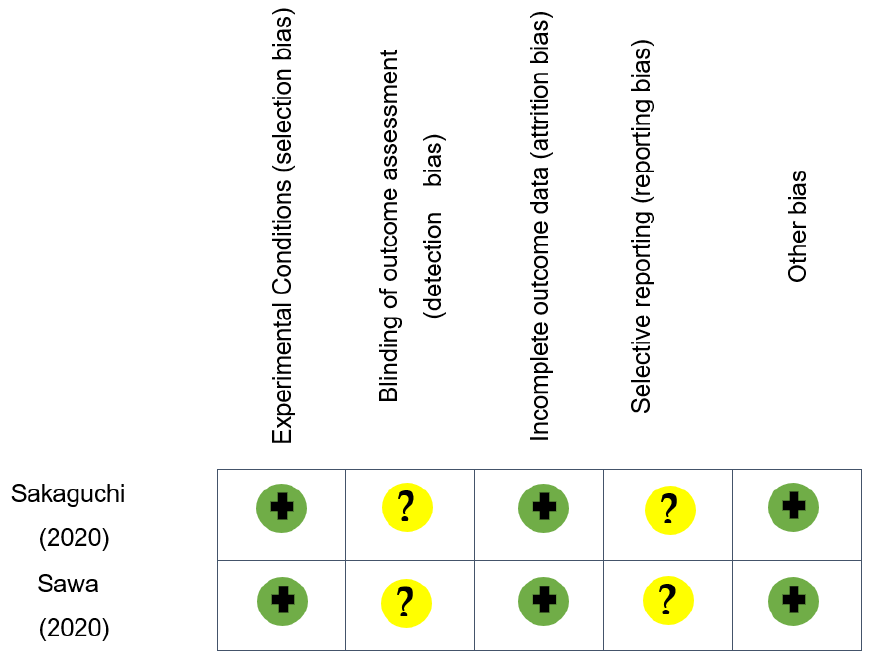
Figure 2. Risk of bias for each of the included in vitro studies ( n = 2). The green circles with plus signs indicate a low risk of bias; the yellow circles with a question mark indicates an unclear risk of bias in the